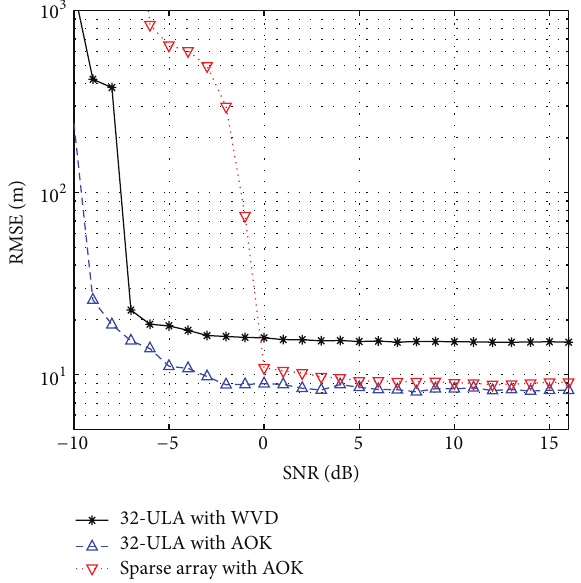
Figure 9: RMSE versus SNR ( 𝑟 1 = 350 m, 𝜃 1 = 30 ∘